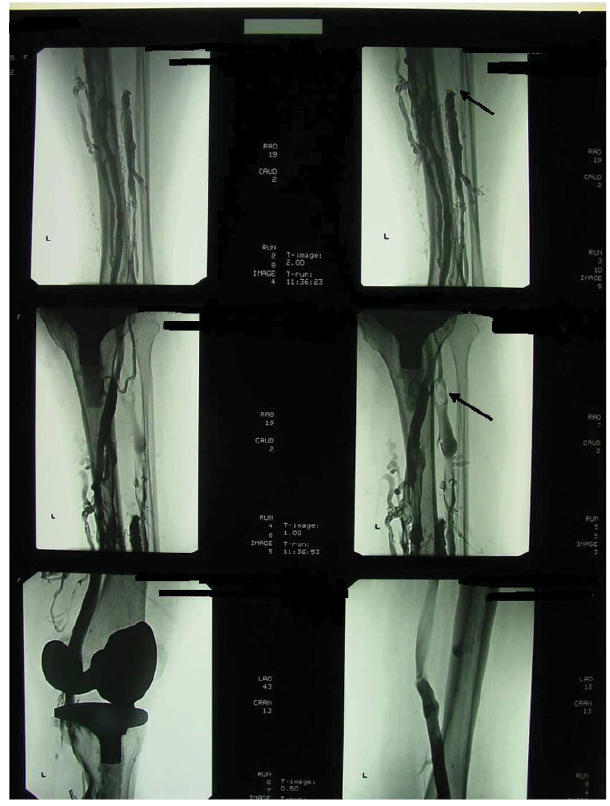
Figure 1 - An ascending venogram of a patient after total knee arthroplasty showing deep vein thrombosis (arrows) in the